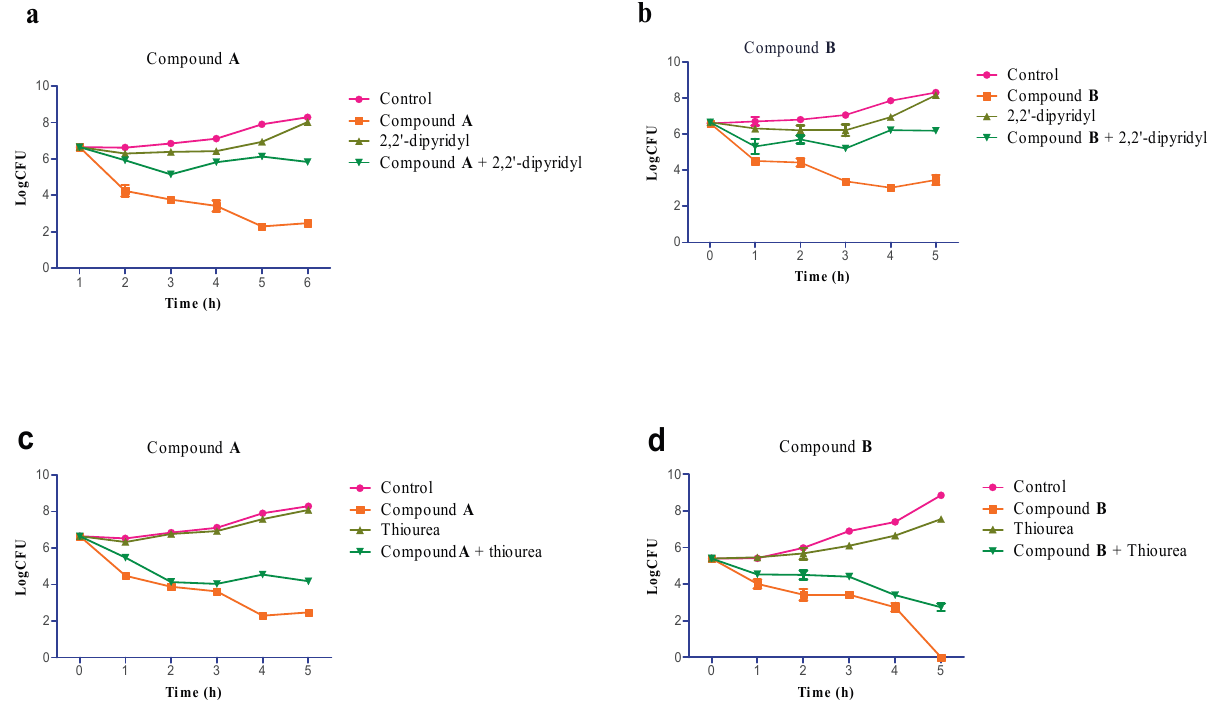
Figure 4. Involvement of hydroxyl radicals in S. aureus inactivation. The survival counts of cells treated with compound A (32 μ g/mL) or compound via B (32 μ g/mL) following the addition of 500 μ M 2,2 ′ -dipyridyl ( a , b ) or 150 mM thiourea ( c , d ). All experiments were performed in